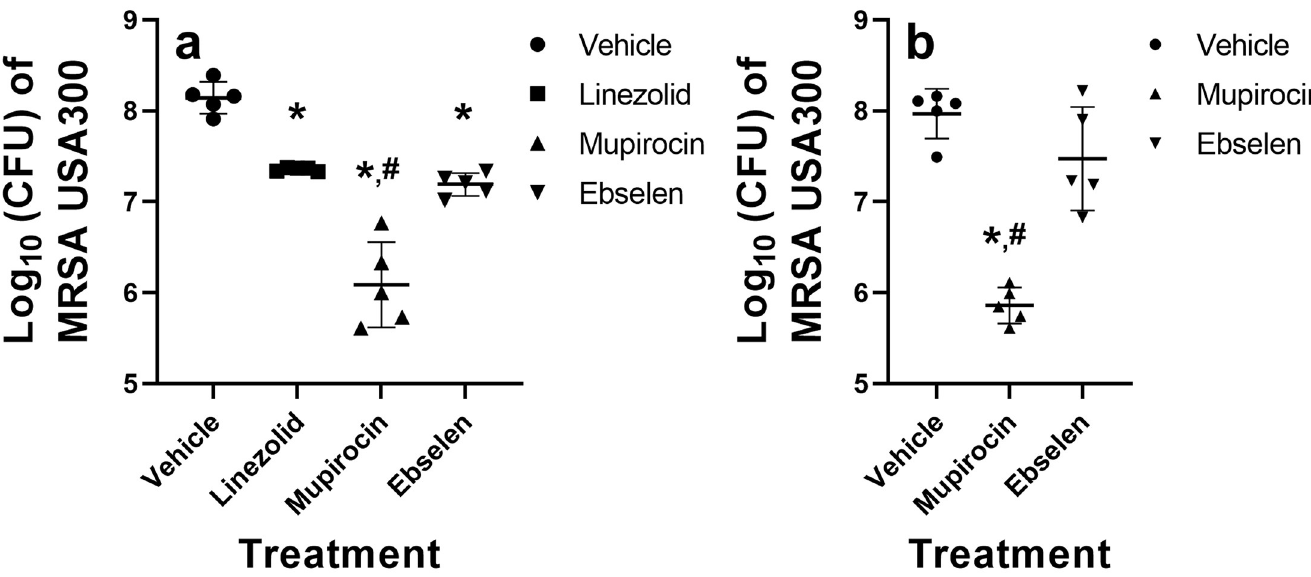
Fig 2. Evaluation of ebselen or mupirocin treatment of infected pressure ulcers in obese and diabetic TALLYHO/JngJ mice. The skin of female (obese) and male (diabetic) TALLYHO/JngJ mice (n = 5) were exposed to magnets to form pressure ulcers that were subsequently infected with MRSA USA300. Approximately 48 hours later, PUs were treated with oral linezolid (10 mg/kg, only for obese mice), topical mupirocin (2%), topical ebselen (2%) or vehicle alone (petroleum jelly) twice daily for either five (obese mice) or four (diabetic mice) days. Mice were humanely euthanized 12 hours after the final treatment dose and the infected PUs were aseptically removed to determine bacterial burden. (a) Reduction in burden of MRSA USA300 in pressure ulcers after treatment with the vehicle alone, linezolid, mupirocin, or ebselen in female obese TALLYHO/JngJ mice. (b) Reduction in burden of MRSA USA300 in pressure ulcers after treatment with the vehicle alone, mupirocin, or ebselen in male diabetic TALLYHO/JngJ mice. Data are presented as log 10 (total MRSA CFU per wound) for each mouse and were evaluated using a one-way ANOVA with post-hoc Dunnet’s test for multiple comparisons. An asterisk ( � ) indicates statistical difference for test agents relative to petroleum jelly (negative control, P < 0.05) while a pound sign (#) indicates statistical difference between mice treated with mupirocin compared to ebselen ( P < 0.05).